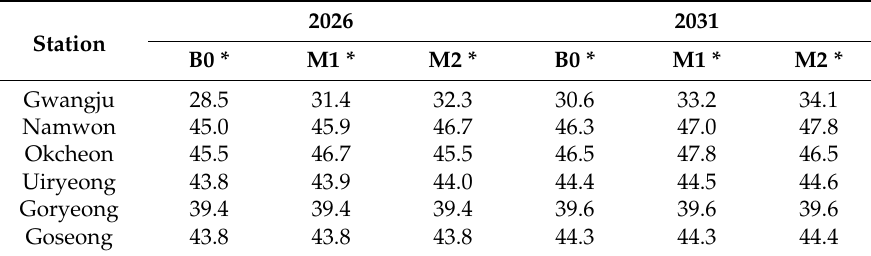
Table 18. Fault currents in 2026 and 2031 after reinforcement.